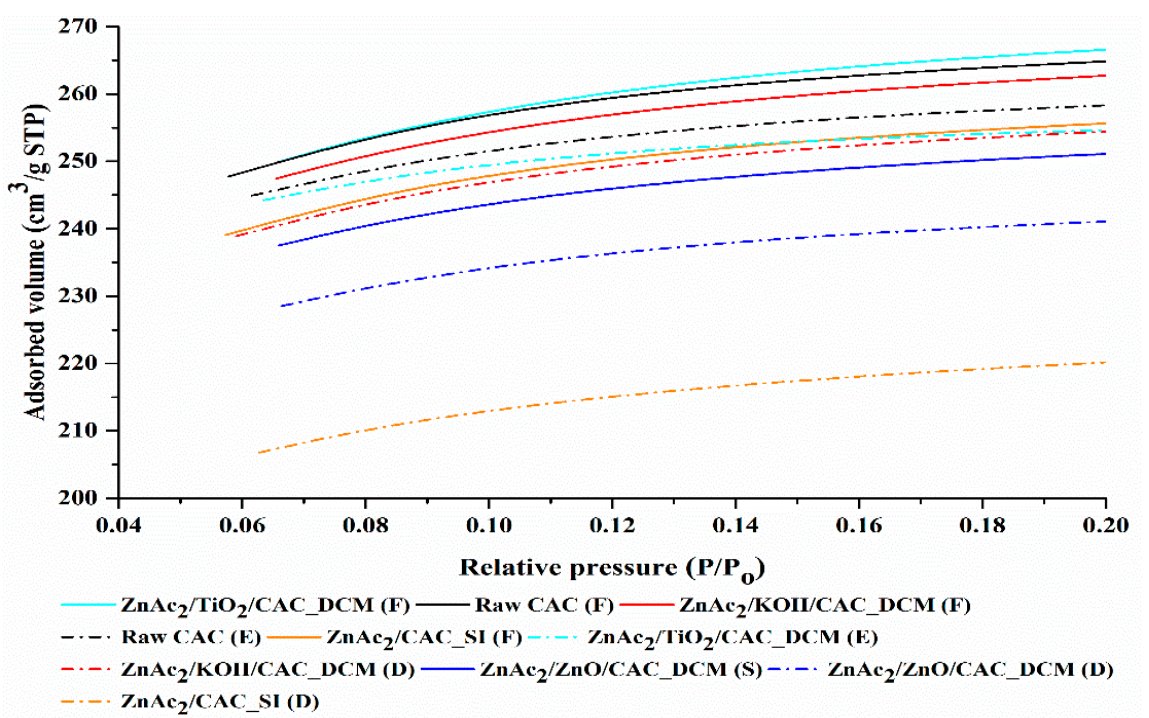
Figure 10. N 2 adsorption isotherm curve for exhausted DCM/CAC, SI/CAC, and raw CAC adsor- bents with 150 °C desorption operating temperature.